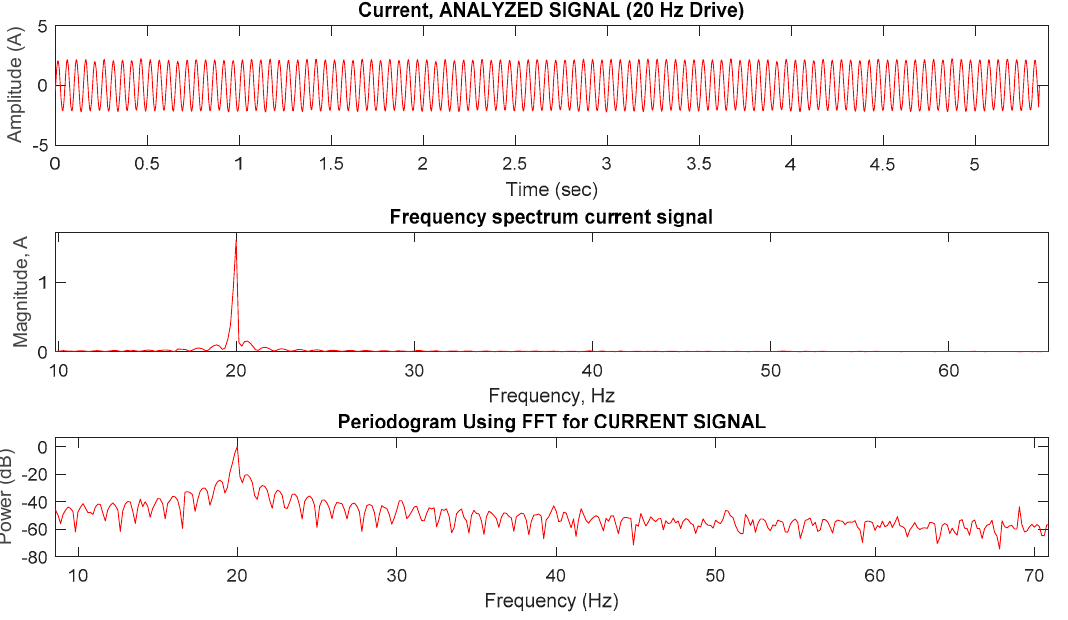
Figure 12. FFT analysis of current signal measurement of motor line current of phase A, frequency spectrum, and periodogram at 20 Hz speed operation.